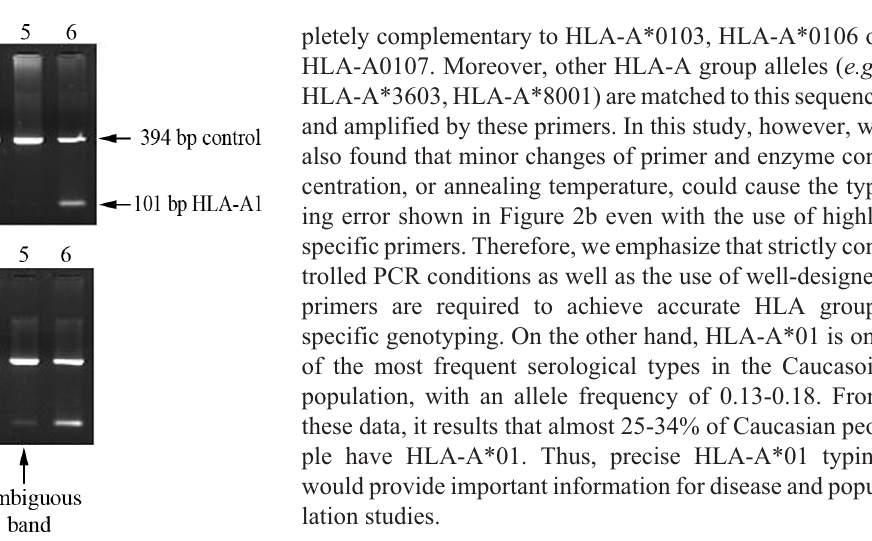
Figure 2 - Band pattern of HLA-A*01 genotyping. a. HLA-A*01 geno- typing result based on the optimized PCR conditions. The visible band at 101 bp in lane 6 is derived from the HLA-A*01 allele. A control band at 394 bp can be seen in each lane, indicating that genomic DNA from each sample was successfully amplified. b. HLA-A*01 genotyping result using 2 °C lower annealing temperature. The visible band at 101 bp in lane 6 is derived from the HLA-A*01 allele. Under these conditions, an ambiguous band is present in lane 5. This individual was HLA-A*11, which has se- quence similarity to HLA-A*01 at the primer